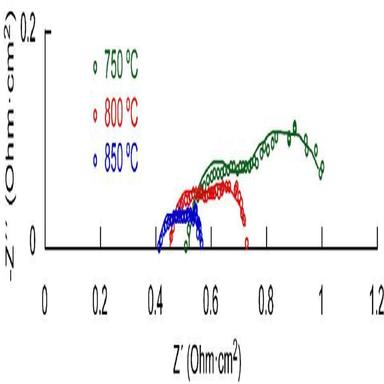
EIS measurements of the cell at 750, 800 and 850 C.